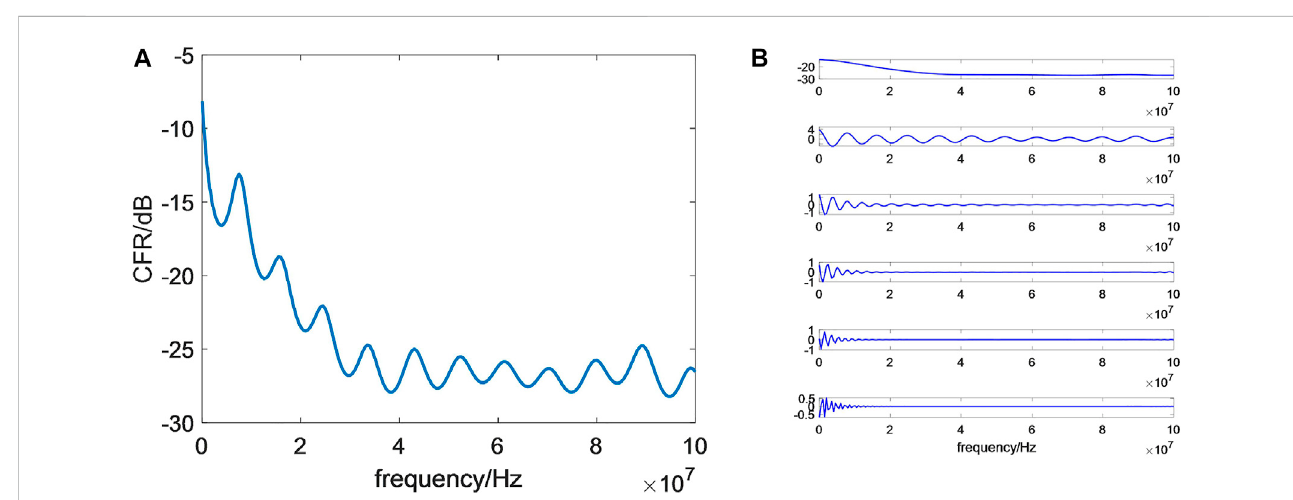
FIGURE 5 A set of CFR data and VMD result. (A) is the CFR data, (B) is the VMD